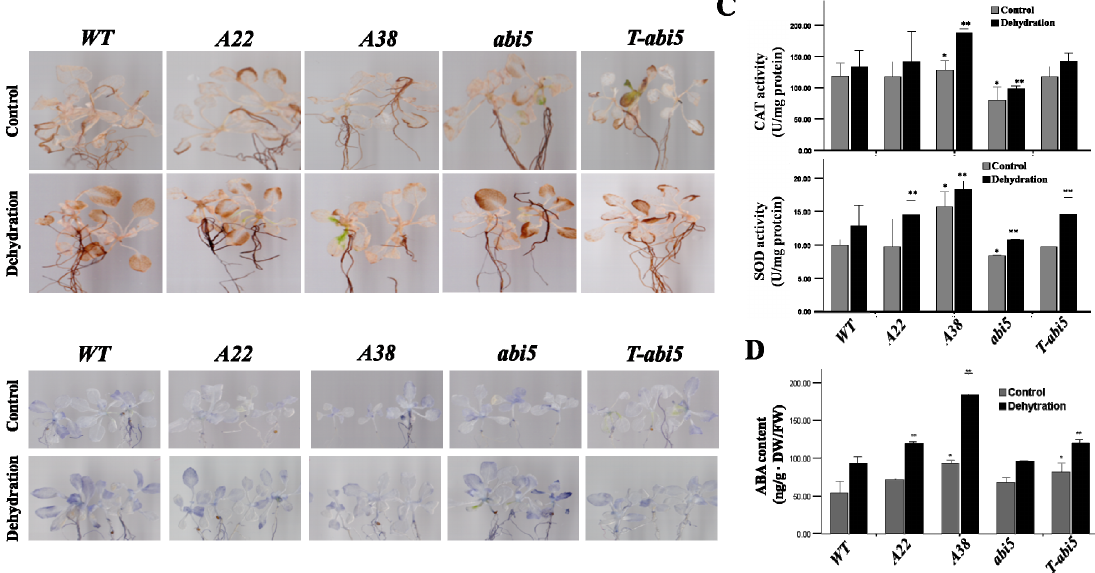
Figure 3. Constitutive expressions of AhAREB1 decreases ROS levels, but enhanced ABA content. ( A , B ) Twenty day-old plants were grown on agar plates, then dehydrated for 0.5 h. − were stained with 3,3-diaminobenzidin (DAB) and nitro Cellular levels of H O and O 2 2 2 − , respectively; ( C ) Twenty day-old plants blue tetrazolium (NBT) to visualize H O and O 2 2 2 were grown on agar plates and then dehydrated for 0.5 h. Catalase (CAT) and superoxide dismutase (SOD) activities were calculated in WT, A22 , A38 , abi5 and T-abi5 plants. All experiments were repeated at least three times, and about 20 plants collected from seedlings were inspected in each experiment; ( D ) Endogenous ABA content was detected in whole plants of WT, A22 , A38 , abi5 and T-abi5 . Fourteen day-old plants were grown on soil for 14 days, then dehydrated for 10 days and were subsequently collected to measure endogenous ABA. Data are presented as the mean ± standard deviation. WT represented wild-type plants; A22 represented A22 transgenic lines; A38 represented A38 lines; abi5 represented the abscisic acid-insensitivity mutant, abi5-1; T-abi5 represented the plants that transformed AhAREB1 into abi5